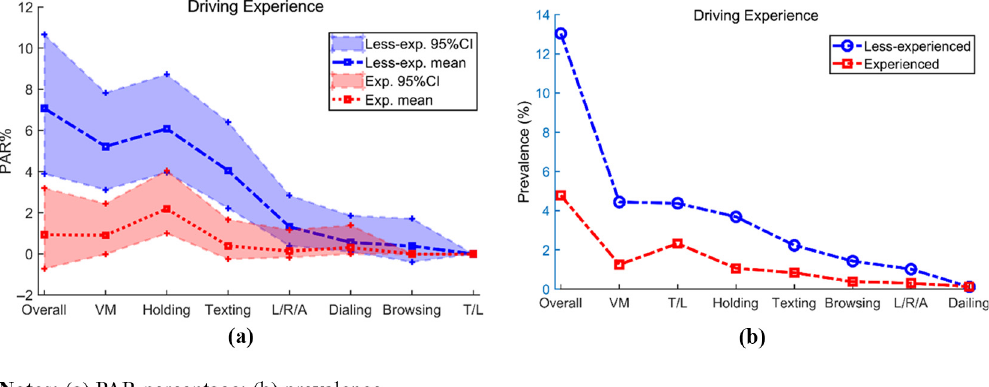
Figure 2 PAR percentage and prevalence analysis results of the driving experience